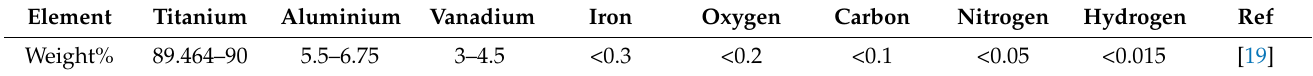
Figure 1. Computer numerical control die-sinking EDM. Table 1. Ti-6Al-4V Chemical